Question: Provide a one-line summary of what is displayed.
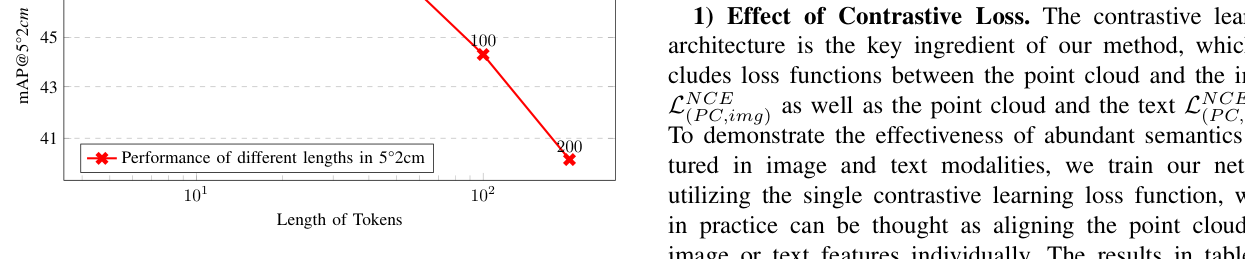
Answer: Visualization of ablation studies on prompt length. The model exhibits improved performance when the length is kept at 50 or below. As the length increases, the outcomes tend to decline.